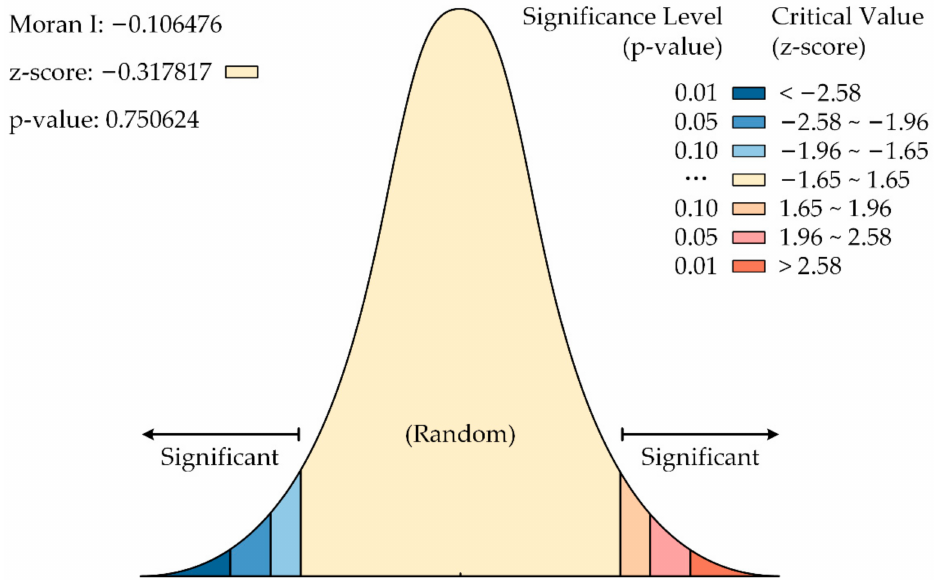
Figure 11. Global Moran’s Index report.